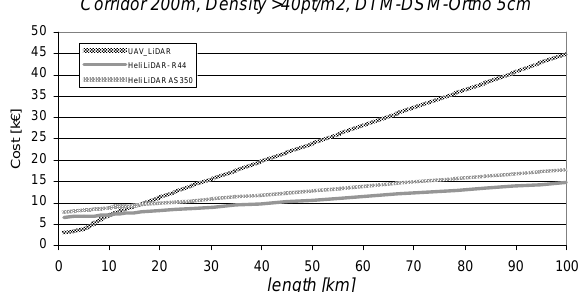
Figure 19: Cost curve for manned and unmanned LiDAR on corridor